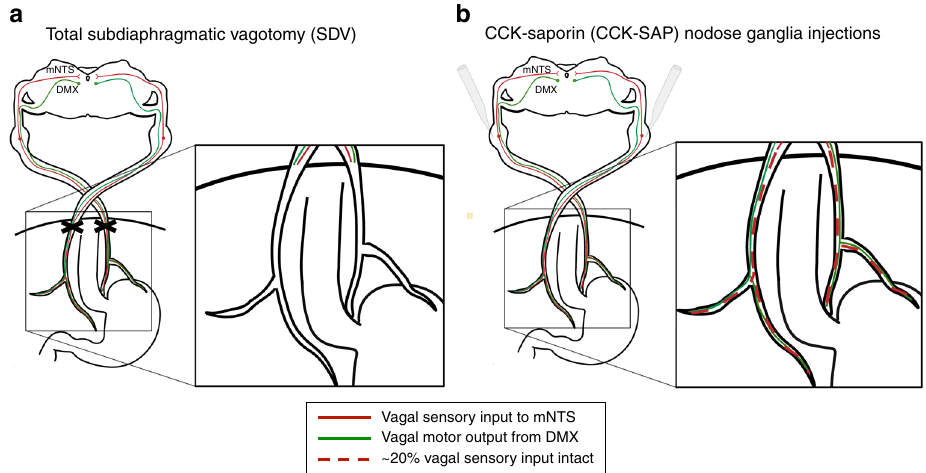
Fig. 1 Schematic illustration of subdiaphragmatic vagus nerve ablative disconnection methods. a Classic total subdiaphragmatic vagotomy (SDV) surgical method consists of lesioning the dorsal and ventral subdiaphragmatic vagus nerve, eliminating 100% of vagal afferent (sensory) and efferent (motor) signaling below the diaphragm. b The novel CCK saporin (CCK-SAP) approach consists of nodose ganglia injections of saporin conjugated to cholecystokinin to speci fi cally ablate ~ 80% of vagal gastrointestinal (GI)-innervating afferent signaling, while leaving 100% of vagal efferent and supradiaphragmatic vagal afferent signaling intact (see ref. 17 ). (DMX dorsal motor nucleus of the vagus nerve, mNTS medial nucleus tractus solitarius). [Cartoon schematic made by authors based on ref. 42